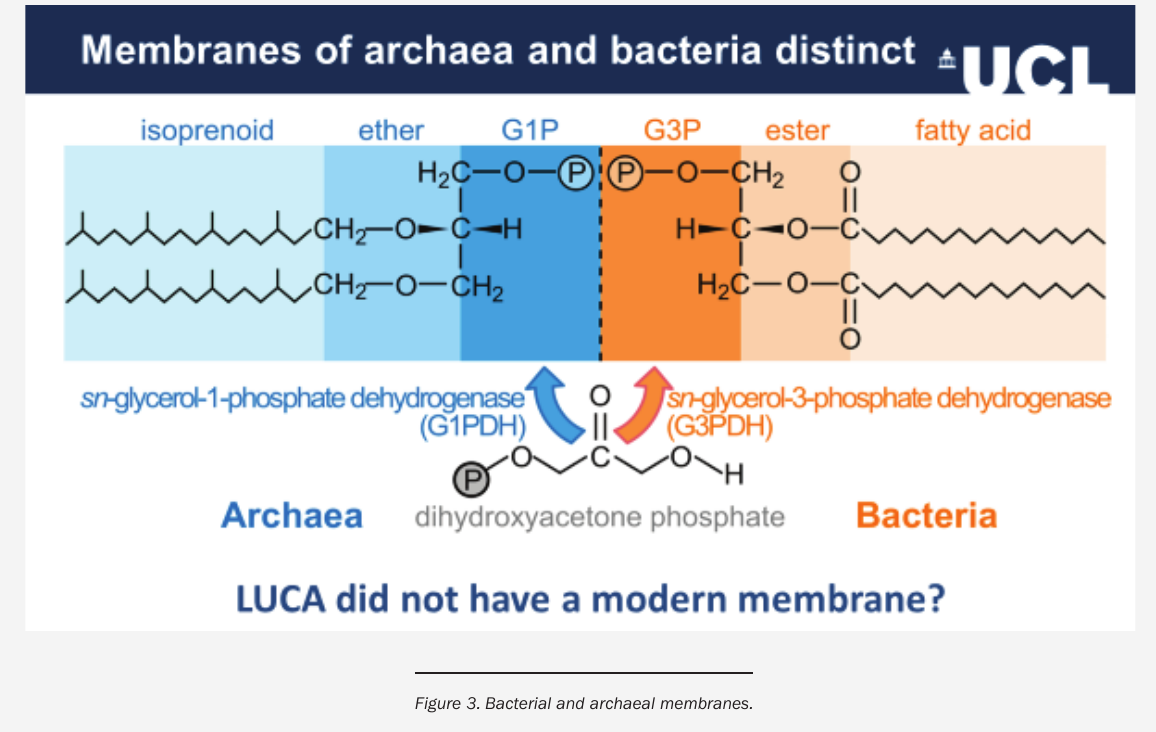
Figure 3. Bacterial and archaeal